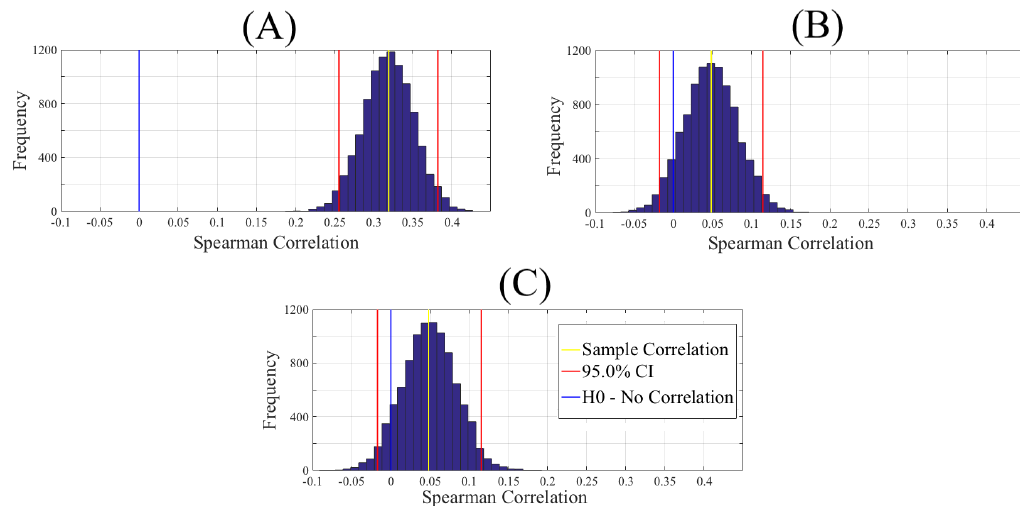
Figure A1. Bootstrap Spearman correlation test (10,000 simulation runs) at 95.0% confidence interval between participants’ DEs (i.e., 62 DEs associated with 62 EEG channels of a participant, per affect) and their corresponding PE3 values (i.e., 62 PEs associated with 62 EEG channels of a participant, per affect) in ( A ) negative, ( B ) neutral, and ( C ) positive. Although PE showed a significant correlation to DE in the negative mental state, such a correlation was non-significant in the case of neutral and positive states. Table A1. Bootstrap (10,000 simulation runs) 95.0% confidence intervals (CI) associated with the Spearman correlation between PEs (i.e., 62 PEs associated with 62 EEG channels of a participant, per affect) and DE (i.e., 62 DEs associated with 62 EEG channels of a participant, per affect) in negative, neutral, and positive mental states.